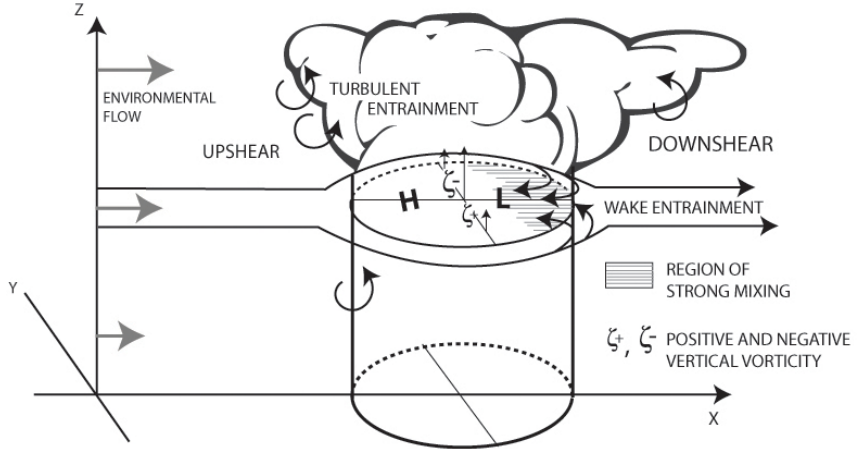
Fig. 2. Schematic of entrainment processes in convective clouds (Adapted from Knupp and Cotton, 1985). Turbulent eddies along the lateral and top boundaries of the cloud entrain environmental air into the cloud. Convective cloud acts as a flow obstruction and leads to positive ( H ) and negative pressure perturbation ( L ) on the upshear and downshear side. Flow patterns associated with clockwise ( ζ + ) and counter clockwise ( ζ − ) rotating vortex couplets that from the southern and northern flanks of the updraft (vertically pointing arrows within the cloud) also reinforce the wake entrainment. Table 1. The name and discrete value ranges of CAPE, SHEAR and PW considered in this study.